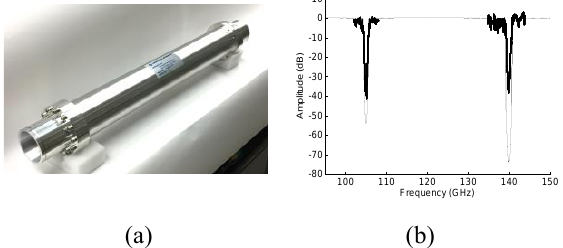
Fig. 9. Dual-notch filter for KSTAR ECE diagnostic in 63.5 mm corrugated waveguide (a). Measured frequency response near 105 GHz and 140 GHz (b).